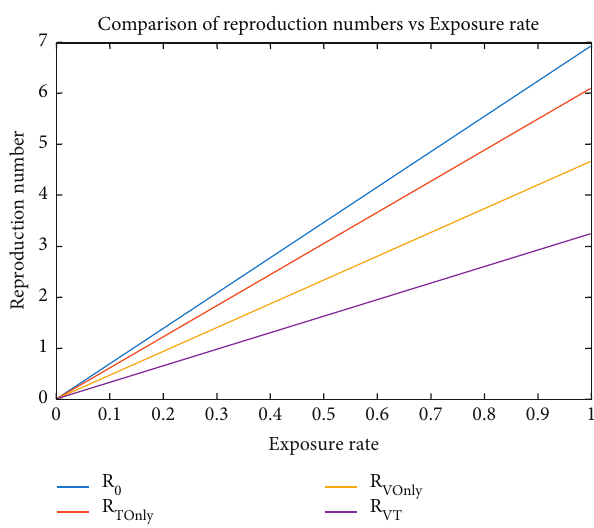
Figure 8: Basic reproduction number and reproduction number with interventions vs exposure